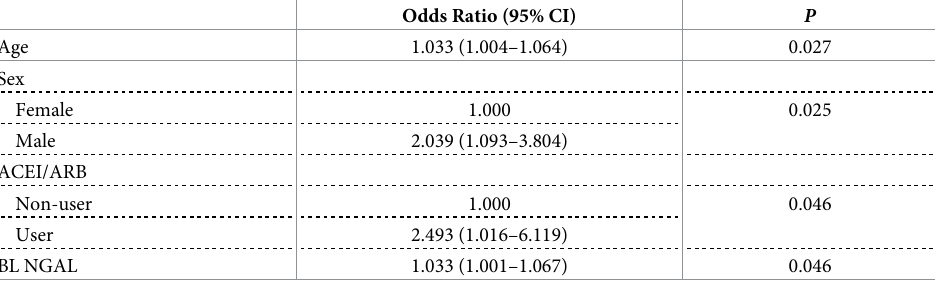
Table 2. Factors associated with grade 2/3 renal function deterioration in chronic hepatitis C patients receiving DAA at